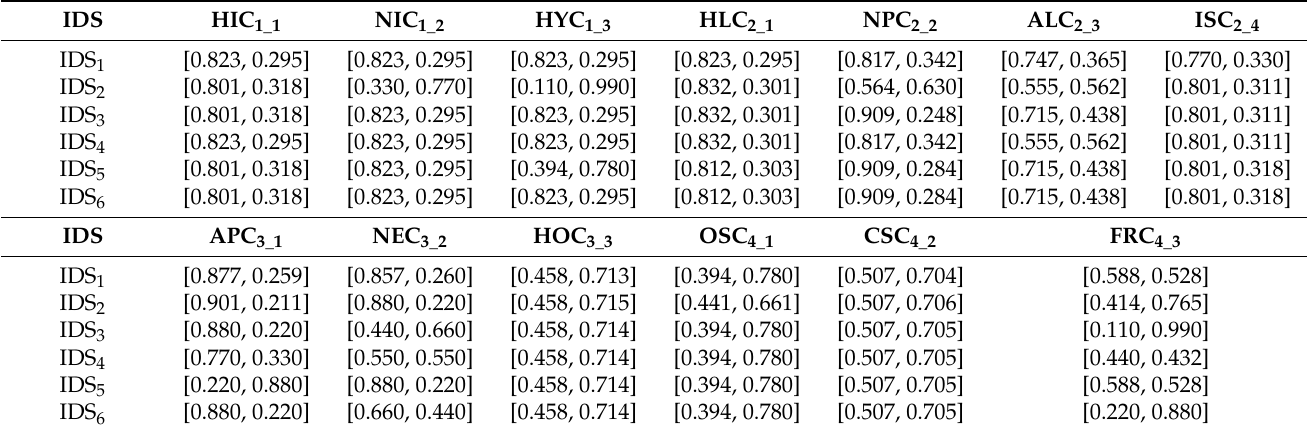
Table 12. The aggregated evaluations matrix of the